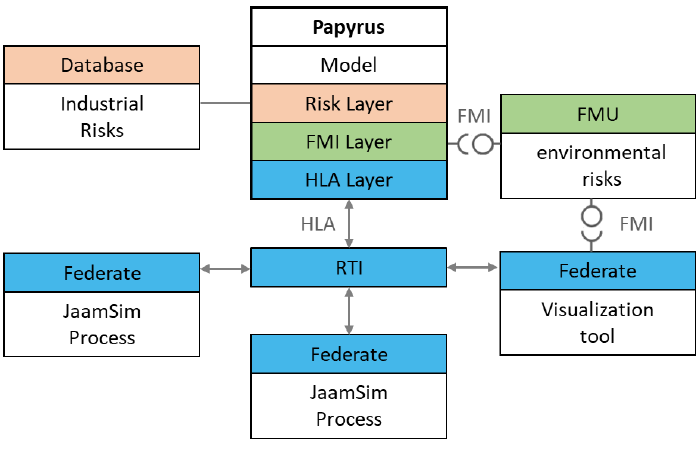
Figure 4. Technical architecture.